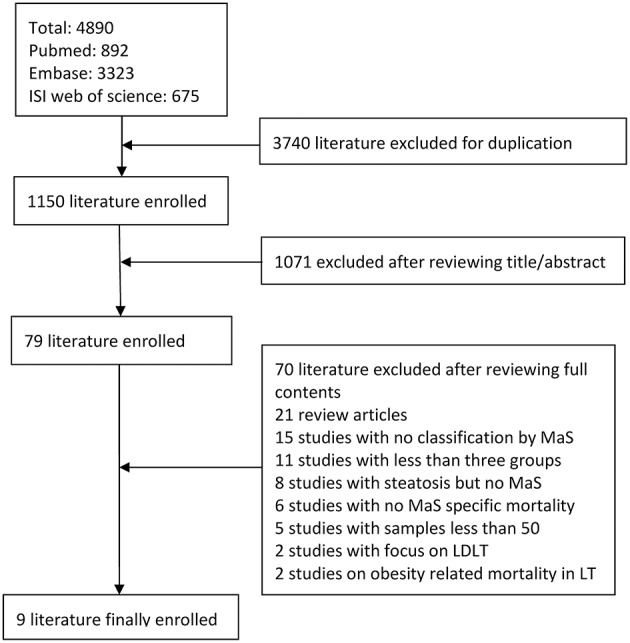
Study flow diagram for selection of qualified studies. MaS, macrovesicular steatosis; LDLT, living donor liver transplantation.